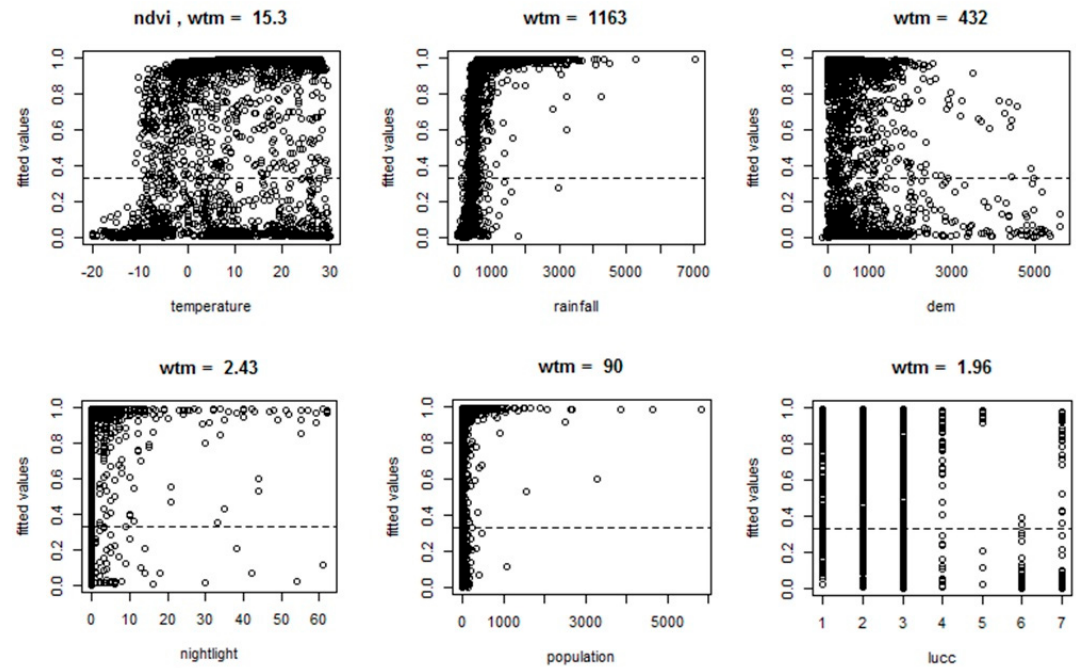
Figure 9. Fitted values in relation to the six predictors used in the model. (Values above each graph indicate the weighted mean of fitted values in relation to each non-factor predictor).